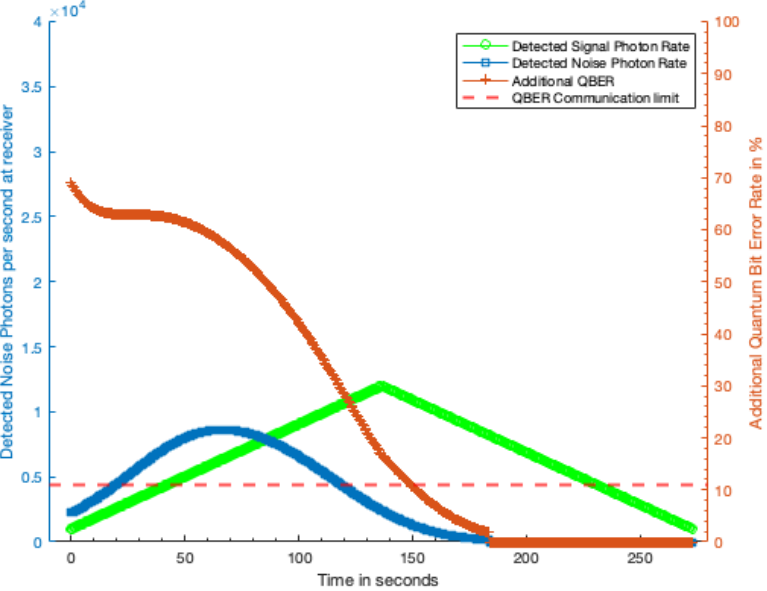
Figure 7. Additional QBER due to laser terminal with 10 cm optic from 1000 km distance with 1 kW laser power. Green trace, detected QKD signal photon rate; blue trace, detected excess noise photon rate; red trace, additional QBER due to excess noise photons; dashed red line, QBER limit at which no secure key can be